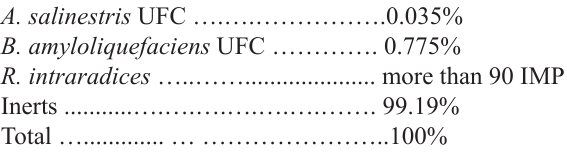
irrigation system by injection. ‘Century’).